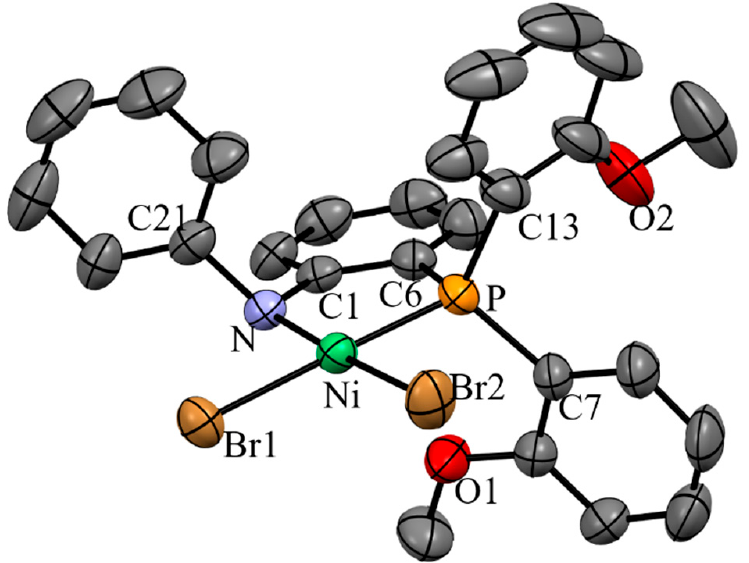
Figure 2. ORTEP representation of complex Ni2 (50% thermal ellipsoids). Hydrogen atoms are removed for clarity. Selected bond lengths (Å) and angles (deg): Ni1 − P1 2.1480(14), Ni1 − N1 1.961(4), Ni1 − Br1 2.3745(6), Ni1 − Br2 2.3132(7), N1 − Ni1 − P1 87.69(10), Br1 − Ni1 − Br2 93.37(2).